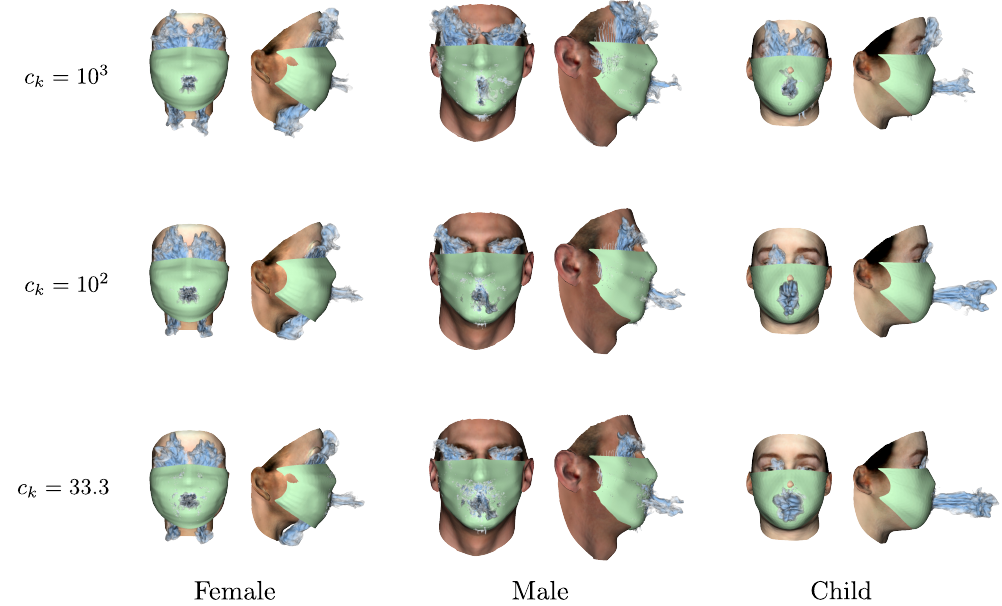
Figure 5. Iso-surface contours of velocity magnitude at the time of peak cough velocity τ = 1 for the three faces and three mask porosities